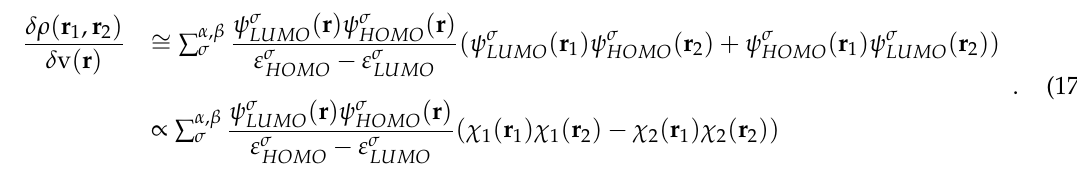
Figure 3. The relationship between the Mulliken charges on the hydrogen atom and δ B HX / δ v ( H ) values for H-X (X = F, Cl, Br, I).